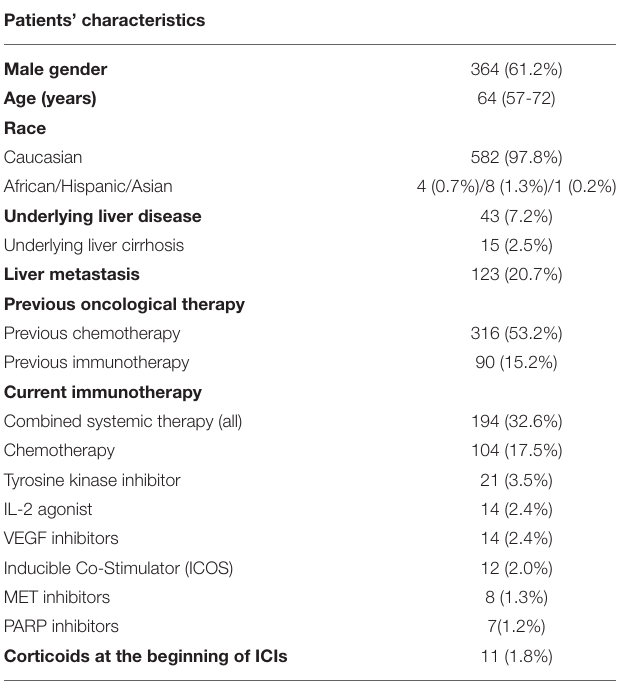
TABLE 1 | Main characteristics of patients treated with immune checkpoint inhibitors ( N =